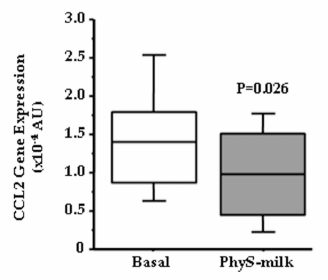
Figure 6. C-C motif chemokine 2 (CCL2) gene expression. Box-plot diagram showing the significant decrease in CCL2 gene expression after the intake of PhyS-milk in the peripheral blood leukocyte fraction of a randomly selected group of subjects ( N = 12; p =